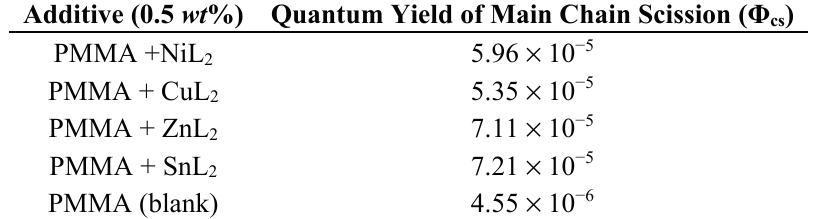
Table 2. Quantum yield ( Φ cs) for the chain scission for PMMA films (40- μ m thickness) with and without additive (0.5% by weight) after irradiation (250 h).